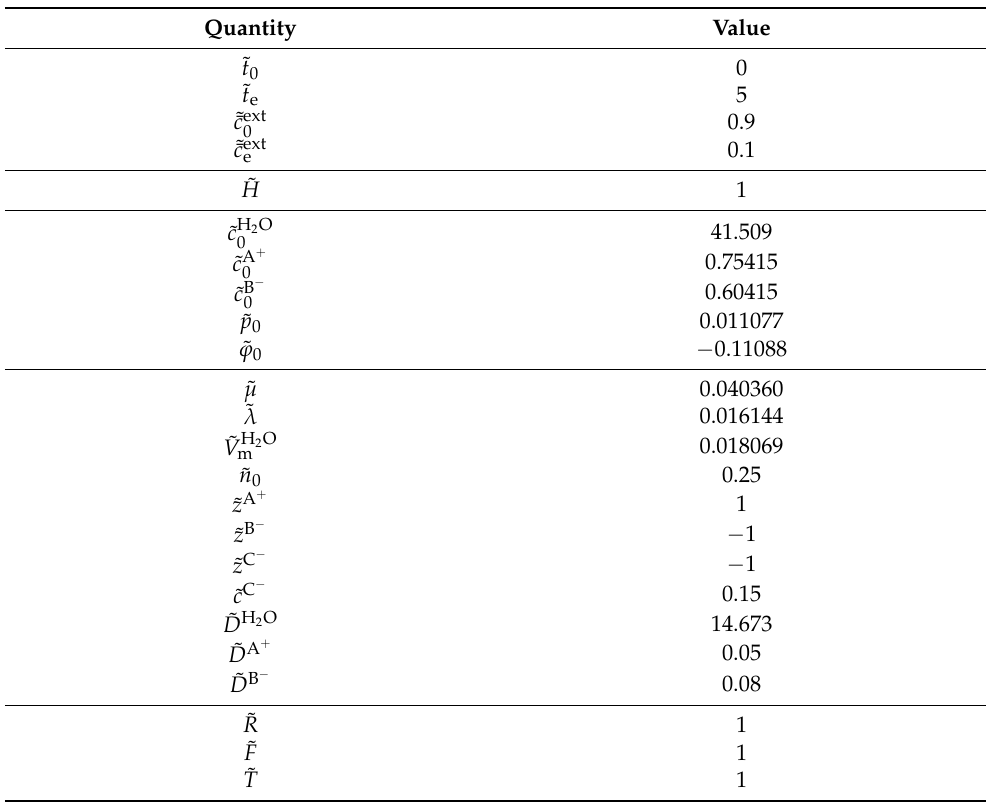
Table 3. The parameters used for the hydrogel